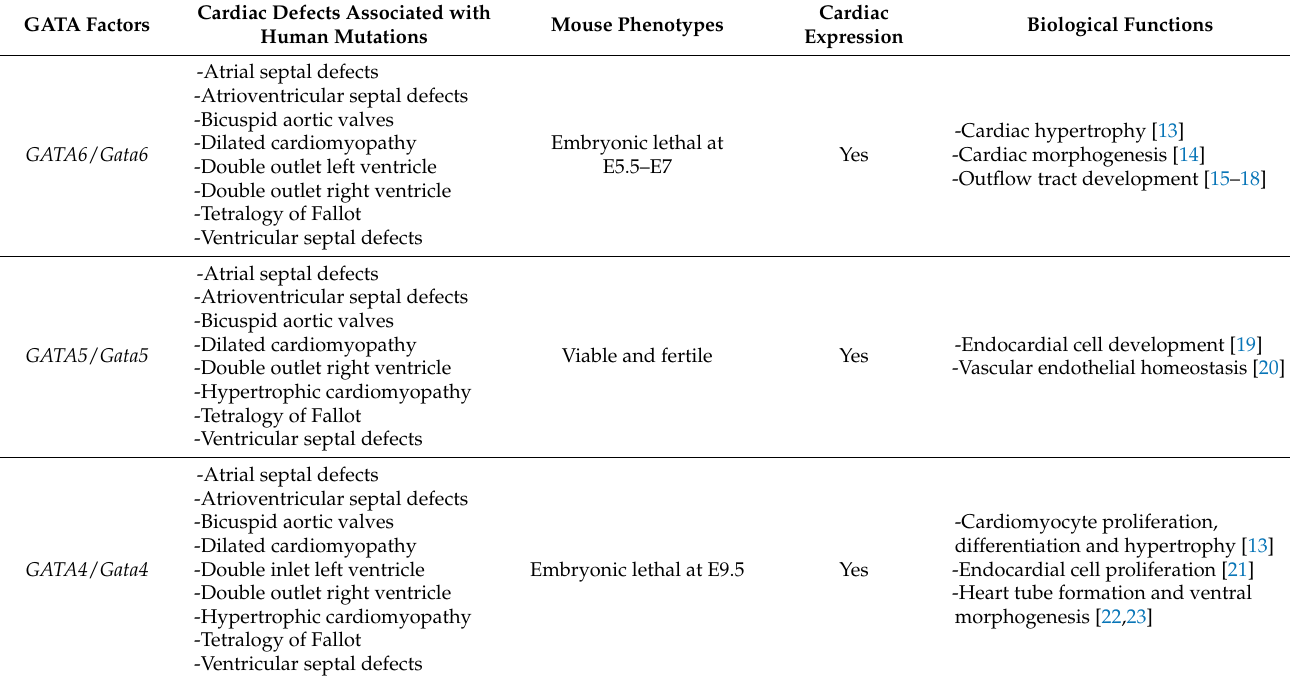
Table 1. The importance of Gata4, 5 and 6 in heart formation. Biological functions and cardiac defects associated in humans and